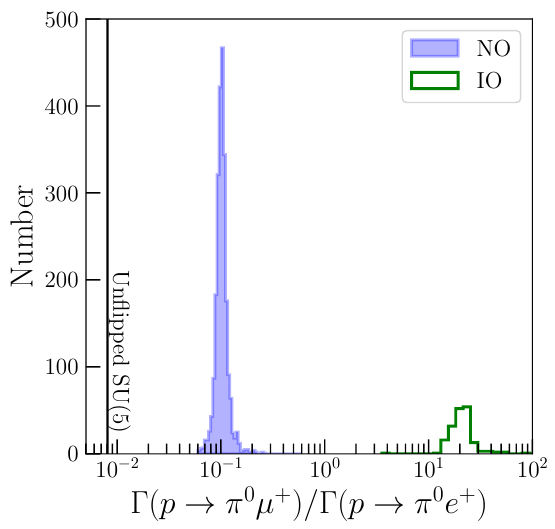
(cid:25) 0 (cid:22) + ) = (cid:0)( p (cid:25) 0 e + ) in the (cid:13)ipped SU(5) GUT model for the NO ! !